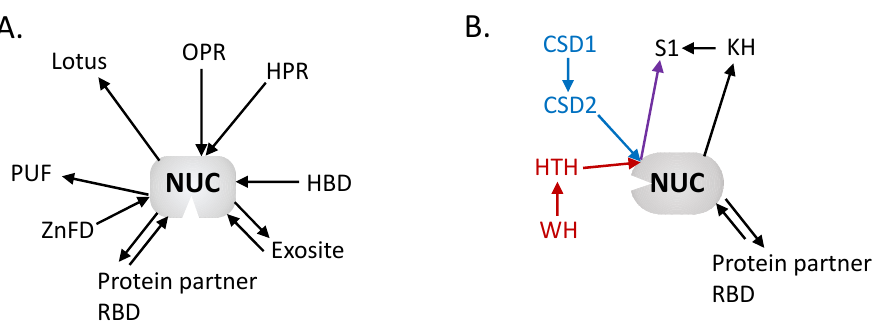
Figure 2. Architectural network of the mitochondria: ( A ) Endoribonuclease and ( B ) 3 ′ -5 ′ Exoribonu- clease domains. The network is centered on the nuclease domains with the diverse RNA binding domains surrounding. The arrows are directed from N to C termini, showing the respective position of each domain. Colored arrows have been added to discriminate different associations (red vs. blue) but that ends with same domain (purple). This highlights the diversity of organization and domains that have been recruited to perform RNA binding in mitochondrial RNases across eukar-